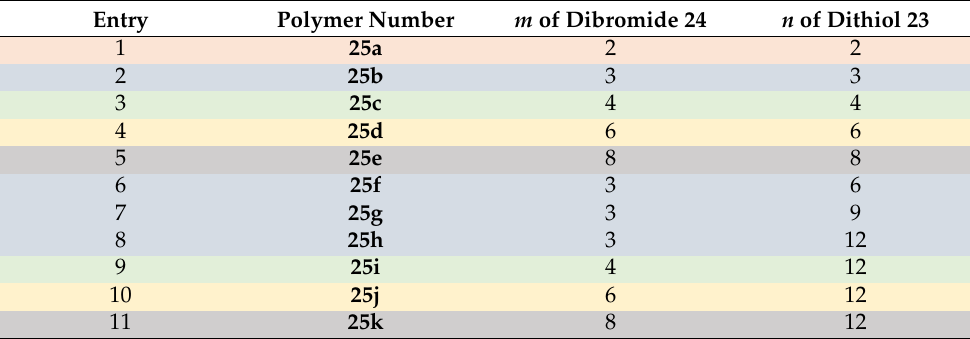
Table 3. Some polymers 25 prepared according to Scheme